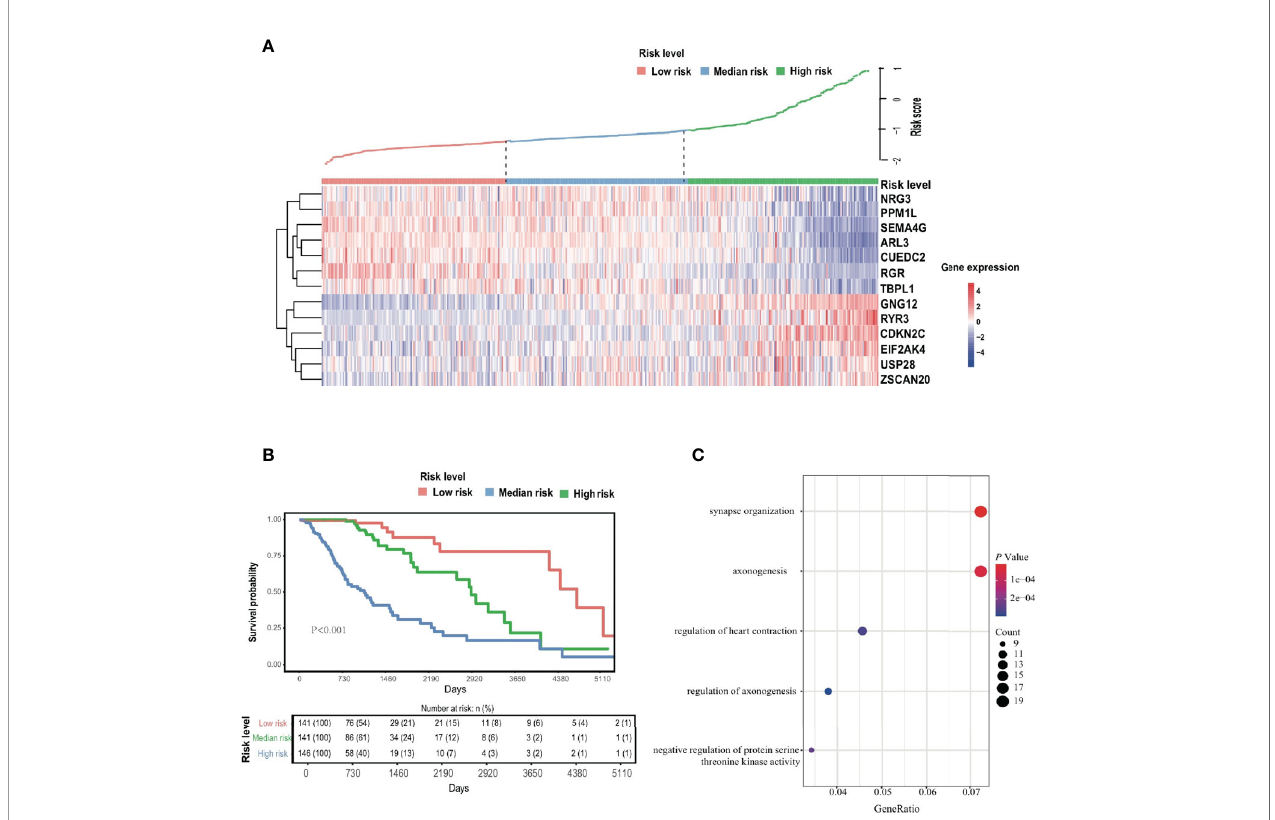
FIGURE 2 | EDGs signature. (A) The Heatmap of 13 screened EDGs expression and distribution of corresponding risk scores among low-, mid- and high-risk subgroups in the TCGA cohort. (B) The Kaplan-Meier analysis for the risk signature. (C) The GO analysis for 289 candidates